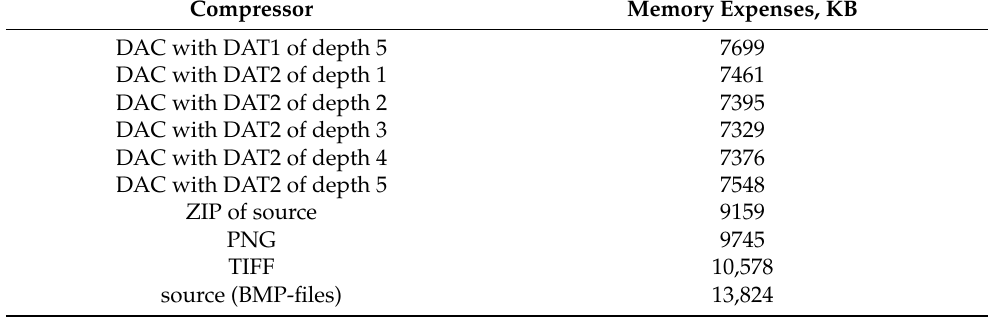
Table 9. Total memory expenses required for storing the compressed and uncompressed data.